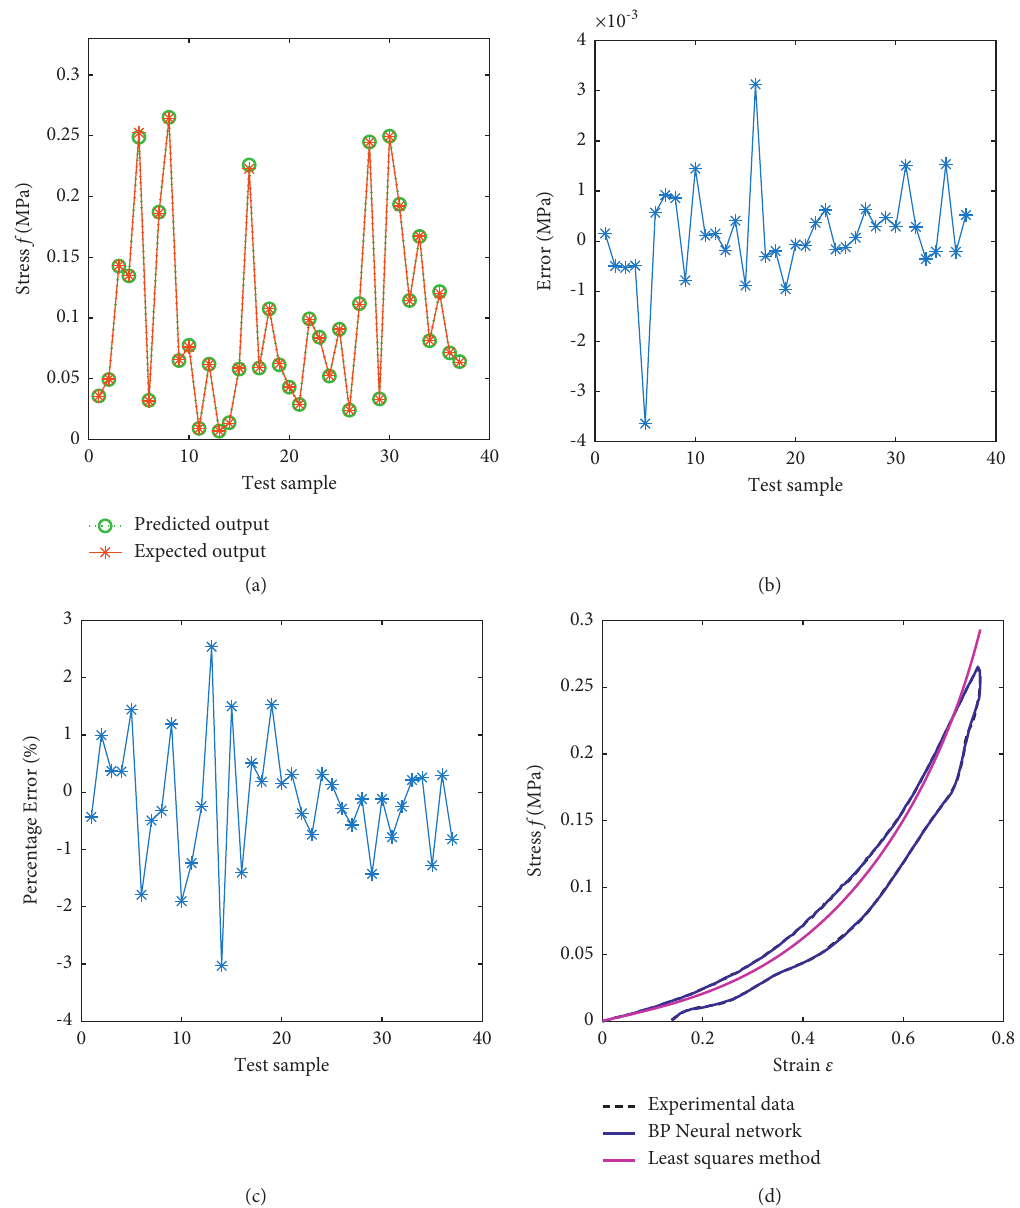
Figure 5: Prediction result of expanded polyethylene. (a) and (b) show the error between expected and predicted output; (c) shows the ratio of error to expected output; (d) shows the result of data fitting using the trained BP